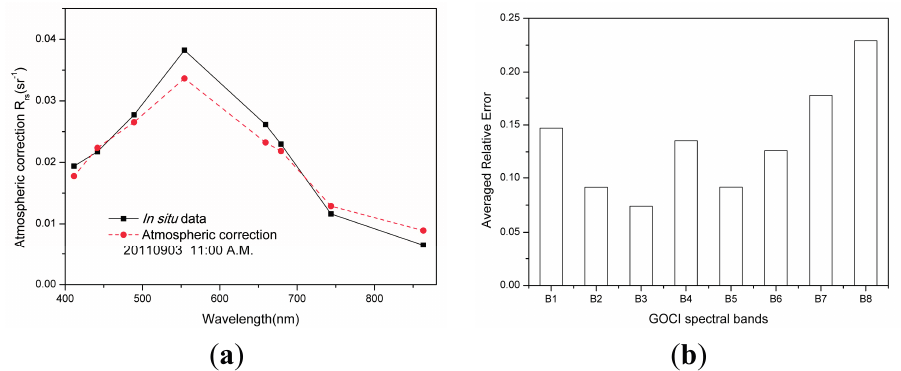
Figure 7. Atmospheric correction results of GOCI data: ( a ) comparison of the in situ data and the atmospheric correction results at 11:00 a.m., 3 September 2011; and ( b ) statistics of the averaged relative error of each band of the GOCI data.